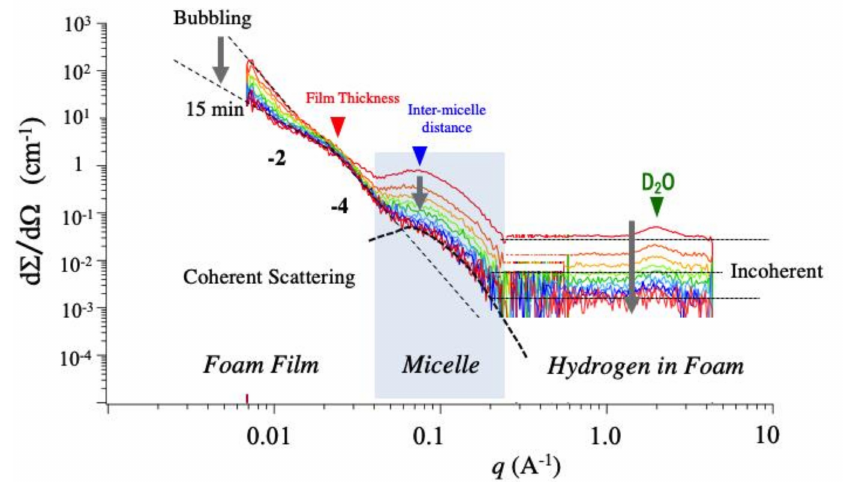
Figure 14. Time-resolved, small-angle scattering obtained for vanishing foam. Di ff erent colors indicate the scattering profiles obtained at di ff erent times between 1 and 15 min with a time interval 1 min. The details of the date analysis are described in